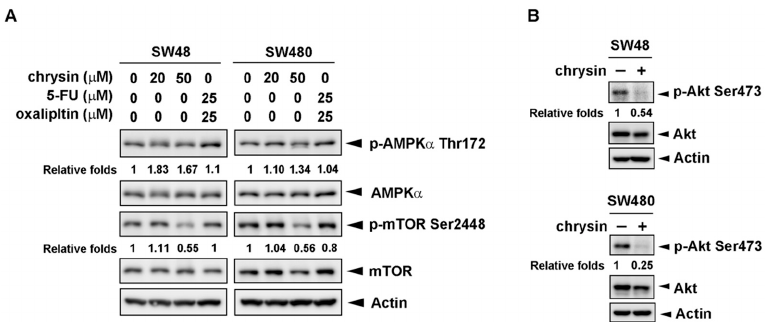
Figure 5. The protein kinase B (Akt)/mammalian target of rapamycin (mTOR) signaling pathway was inhibited in chrysin-treated but not 5-fluorouracil (5-FU)/oxaliplatin-treated colorectal cancer (CRC) cells. ( A , B ) SW48 and SW480 cells were treated with the indicated concentrations of chrysin or 5-FU/oxaliplatin for 24 h. Then, cells were harvested for western blot analysis. Expressions of phosphorylated AMP-activated protein kinase alpha (p-AMPK α ) threonine 172, AMPK α , phosphorylated mTOR (p-mTOR) serine 2448, mTOR, phosphorylated Akt (p-Akt) serine 473, and Akt were examined using the indicated antibodies. The band images were quantified using both actin and the AMPK α , mTOR, or Akt proteins as calibrated controls. Relative fold inductions of p-AMPK α threonine 172, p-mTOR serine 2448, and p-Akt serine 473 were indicated as compared to control (vehicle alone) groups.